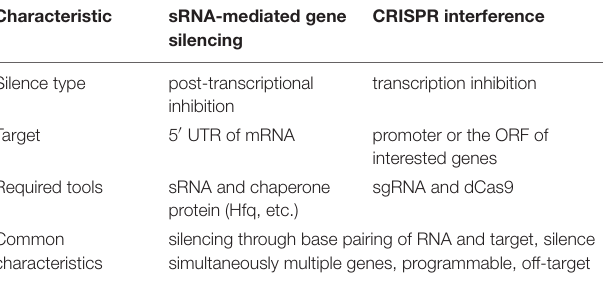
TABLE 2 | Comparison of sRNA-mediated gene silencing and